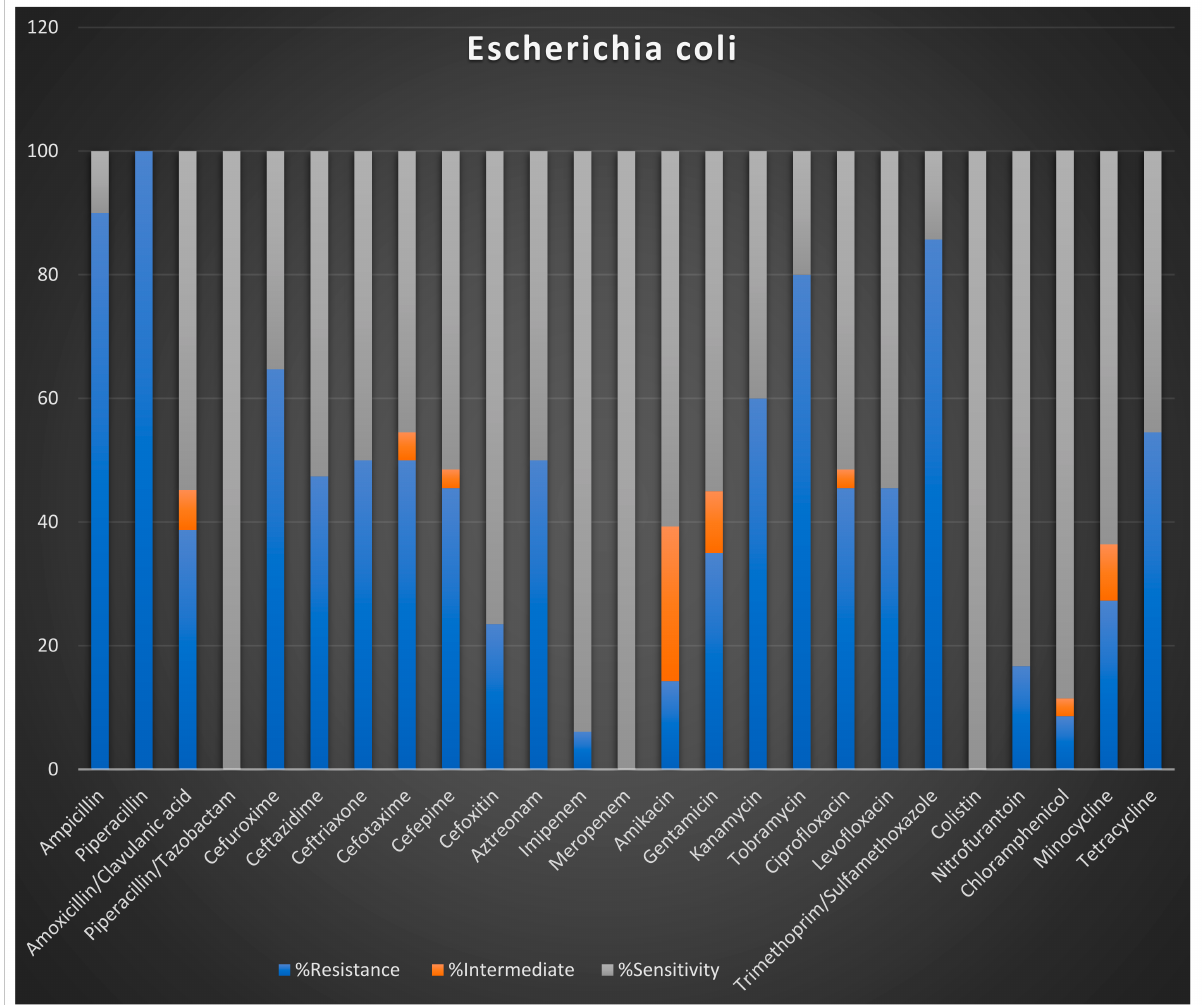
Figure 7. Stacked column graph for E. coli is for Arua Health Region isolates for AST patterns validated by the National